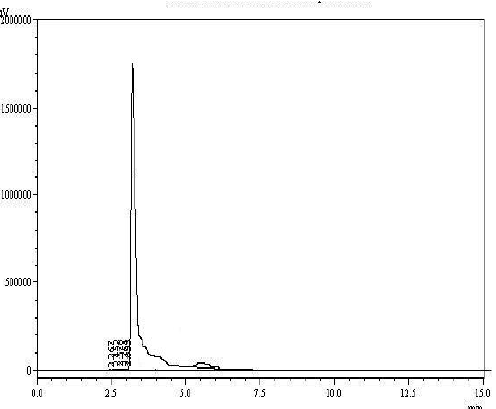
Figure 7: HPLC analysis of Casticin isolated from Vitex agnus-castus